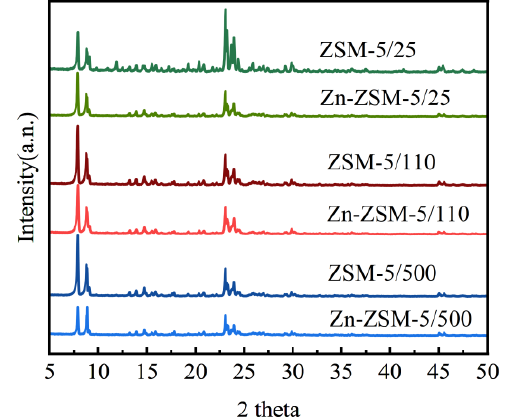
Figure 2. XRD plot of the effect of zinc modified ZSM-5 zeolite.